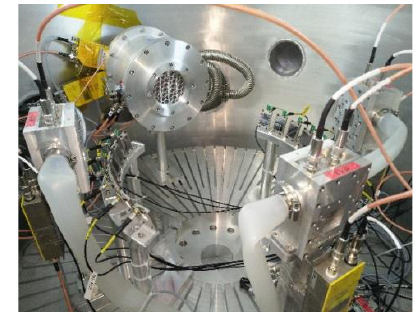
Fig.7. LPDA spectrometer under experiment